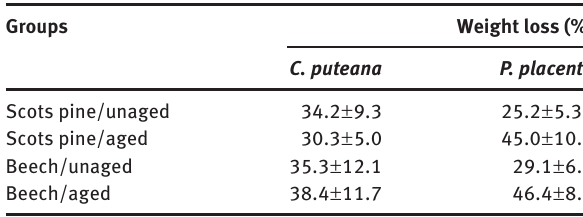
Table 2 Weight loss of samples due to decay